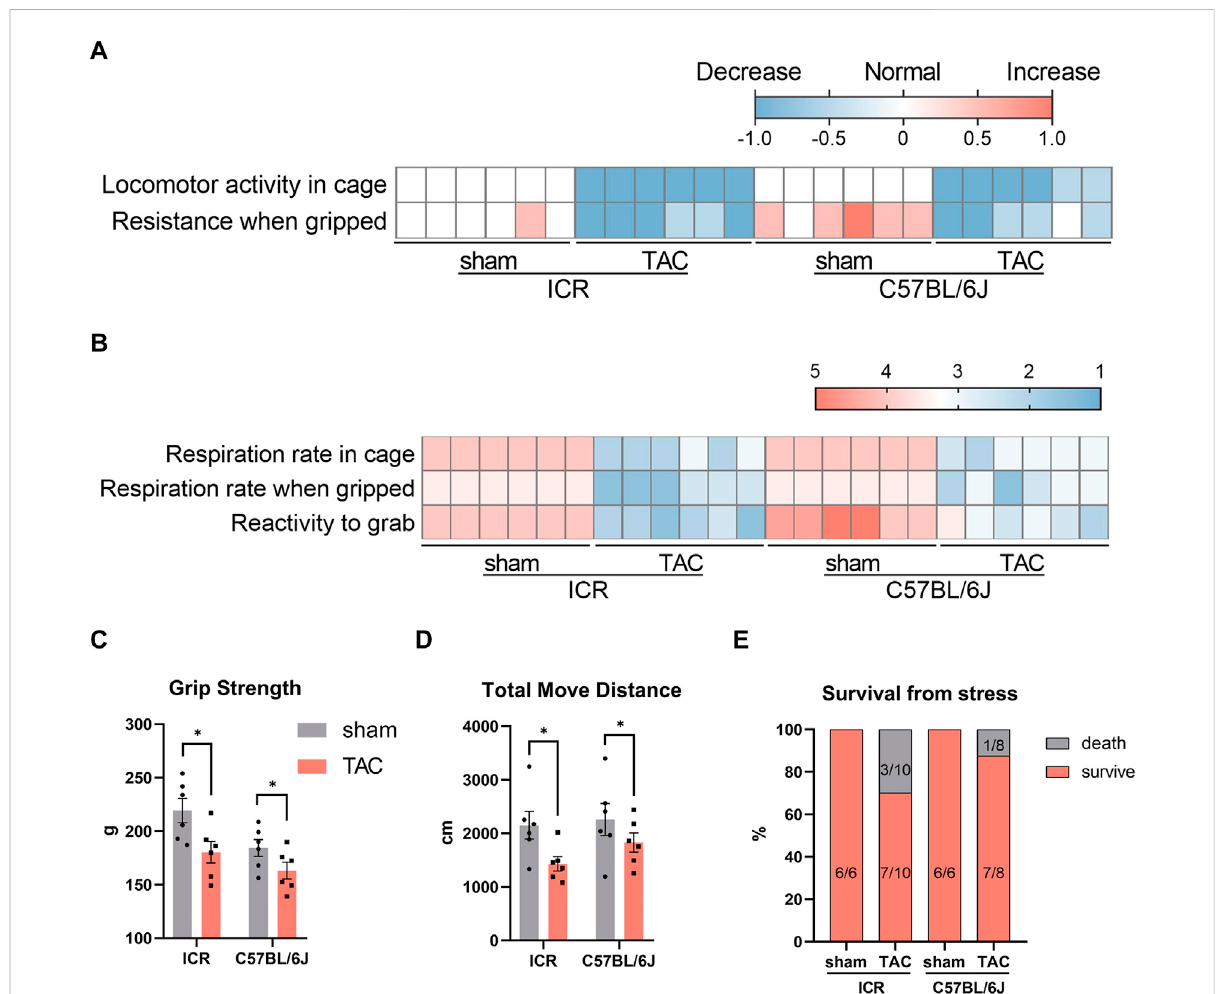
Behavior observation at 4 weeks after TAC in ICR and C57BL/6J mice. (A) Heatmap of locomotor activity in cage and resistance when gripped. Score: normal = 0, decrease = − 1, increase = 1. (B) Respiration rate in cage or gripped and reactivity to grab. Score of respiration: 5 = normal; 4 = slightly incomplete/fast and shallow, bradypnea (breathing either fast and shallow or slow); 3 = moderately incomplete/rapid breathing, dif fi culty breathing (breathing very fast and shallow or very shallow and laboured in appearance); 2 = severely incomplete/wheezing, breathing with mouth open (wheezing or breathing with mouth open); 1 = weak breathing (breathing very little). Score of reactivity to grab: 5 = very easy (sits and allowsitselftobepickedup);4=easy/normal(doesnotresist);3=somewhatdif fi cult(stands);2=dif fi cult(cringesandbecomesrigidorrunsaround and is dif fi cult to grab); 1 = very dif fi cult (attacks). (C) Grip strength measured by a rats/mice grip strength meter. (D) Total move distance calculated from open fi eld observation in 5 min. N = 6 each in (A – D) , quantitative data are shown as mean ± SEM, * p < 0.05. (E) Percent survival from stress like anesthesia, hair removal, echocardiographic